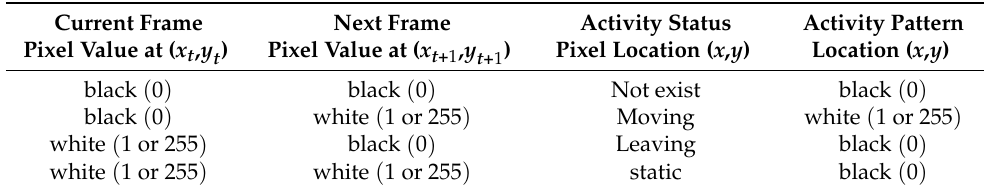
Table 2. The Truth Table of the Growth